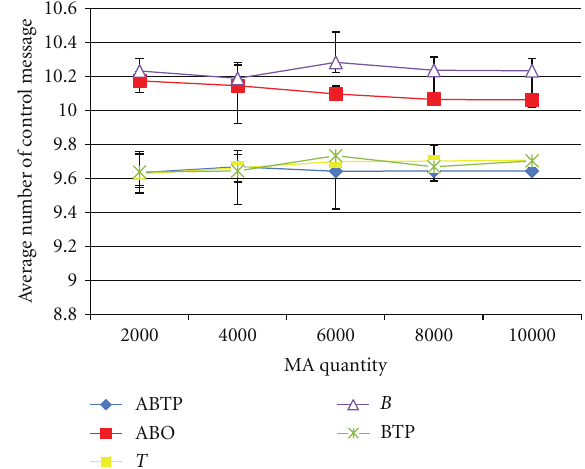
Figure 9: Average number of control messages on di ff erent MA quantity and optimization criteria.